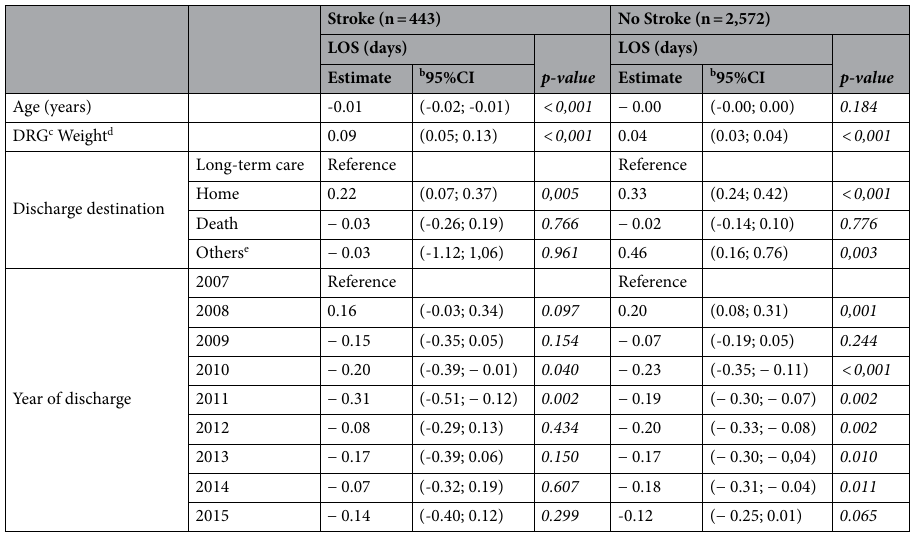
Table 4. Relationship between LOS a by patient characteristics and context of care in patients with stroke and delayed discharge for non-clinical reasons: multivariate analyses. Cantabria (Northern Spain), 2007–2015. a LOS: length of total stay; b 95%CI, 95% confidence interval; c DRG, diagnosis-related group; d DRG weight, complexity in terms of consumption of hospital resources for care provision, based on the average annual cost of hospitalization in acute care units (weight = 1); e nursing homes for people with